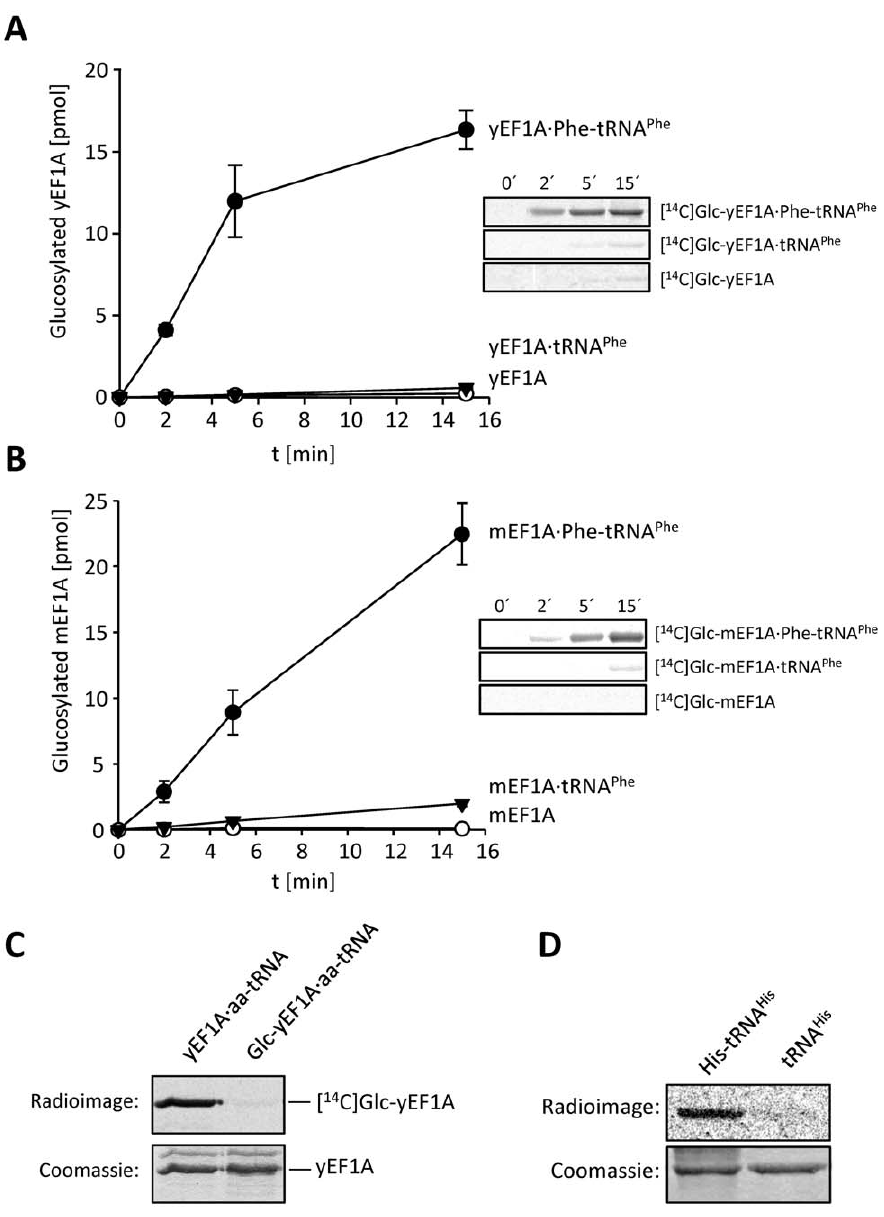
Figure 4. Kinetics of eEF1A glucosylation by Lgt3. Time courses of glucosylation of purified yeast eEF1A (yEF1A) (A) or mouse eEF1A (mEF1A) (B) by Lgt3 in the absence (triangles) or presence of Phe-tRNA Phe (filled circles) or uncharged tRNA Phe (open circles). The glucosylation reactions and analyses were performed under the conditions as described in Figure 1. Values of 14 C-glucose incorporation are shown as the mean ( 6 SD) of at least three independent experiments. The inserts show representative radioimages. (C) eEF1A ternary complex is quantitatively glucosylated by Lgt3. Yeast eEF1A (20 m M) was glucosylated by Lgt3 (5 m M) with Phe-tRNA Phe (20 m M) and GTP (75 m M) in the absence (lane 1) or presence (lane 2) of cold UDP- glucose (1 mM). Modified and unmodified yEF1A were separated by His-eEF1B a affinity purification as described in Materials and Methods. Thereafter, the isolated eEF1A (3 m M each) was subjected to second glucosylation reaction with radiolabeled UDP-[ 14 C]glucose in presence of Phe- tRNA Phe (1 m M) and GTP (75 m M). The Coomassie gel and the autoradiogram are shown. (D) Glucosylation of yEF1A (2 m M) was performed in the presence of His-tRNA His or uncharged yeast tRNA with Lgt3 (140 nM).